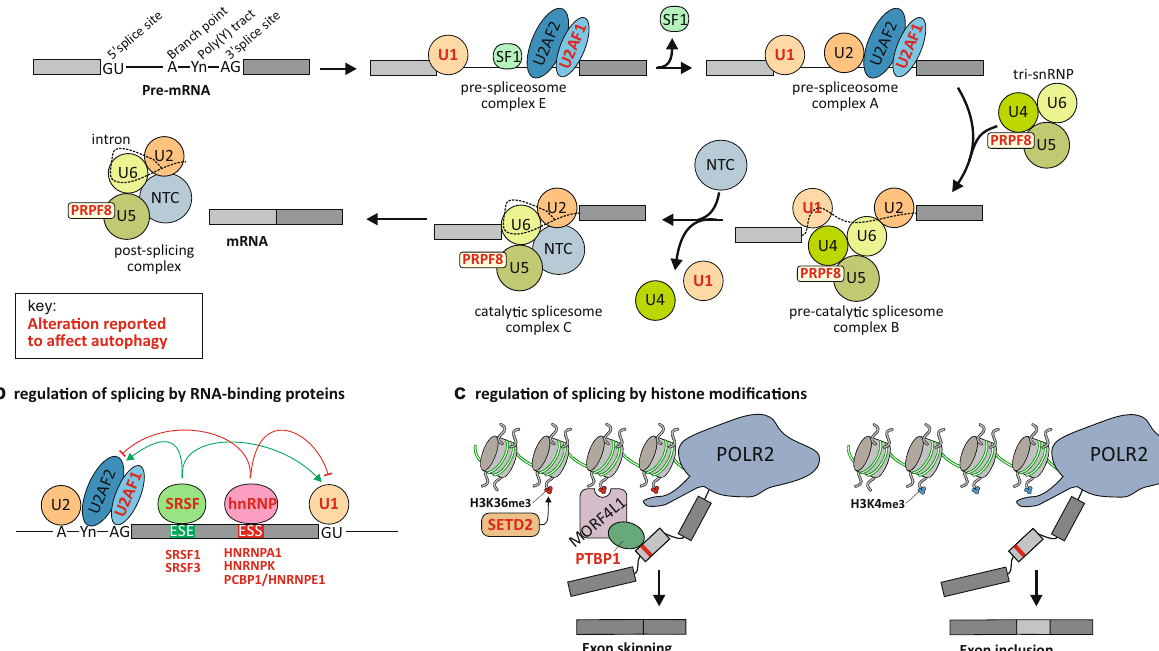
Fig. 2 Alternative-splicing machinery with indication of component alterations impacting on autophagy. ( a ) Schematic representation of the stepwise assembly of the spliceosome from its small ribonucleoprotein (snRNP) components. U1 snRNP recognizes and binds to the 5 ′ splicing site (5 ′ SS), SF1 binds to the branch point site, U2AF2 binds to the polypyrimidine poly(Y) tract and U2AF1 binds to the 3 ′ SS, forming the pre-spliceosome complex E. Next, U2 snRNP replaces SF1 on the branch point site to form the pre-spliceosome complex A. The tri-snRNP, consisting of U5-, U4- and U6 snRNPs, joins complex A to form the pre-catalytic spliceosome complex B. Thereafter, U1 and U4 snRNP leaves, the U6 snRNP binds to the 5 ′ SS, and NTC is recruited so that the U6 snRNP and the U2 snRNP can pair, thereby generating the catalytic spliceosome complex C. Two subsequent transesteri fi cation reactions result in the creation of a post-splicing complex with intron exclusion, and the formation of mature mRNA with interconnected exons. ( b ) Regulation of splicing by RNA-binding proteins (RBPs). SRSF-bound exonic splicing enhancer (ESE) can stimulate splicing at up- and downstream splice sites by facilitating the interaction of U2AF or U1 snRNP with the 3 ′ SS and 5 ′ SS, respectively, on the pre-mRNA. Heterogeneous nuclear ribonucleoprotein epigenetic mechanism such as histone modi fi cations. The recruitment of RBPs can also occur through binding to speci fi c histone marks. For example,